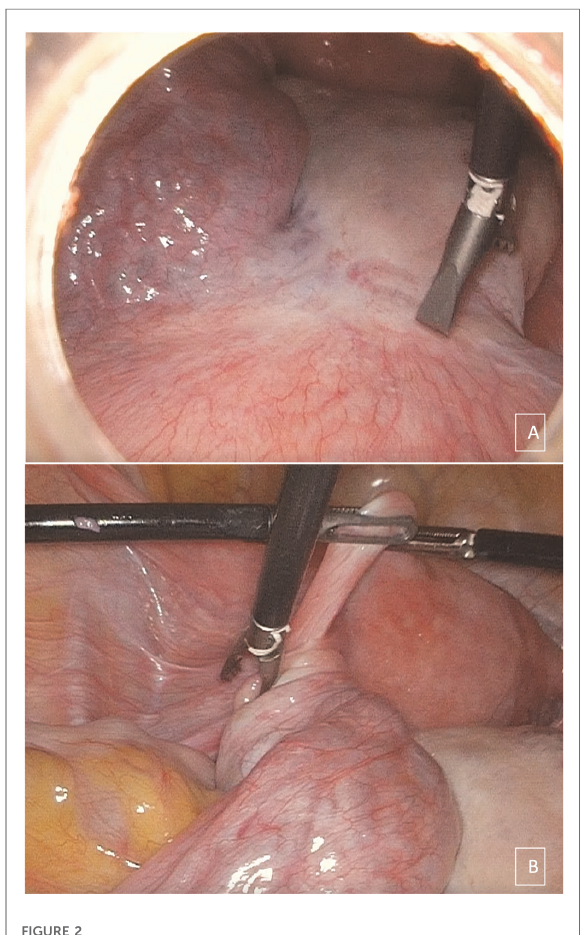
FIGURE 2 Laparoscopic appearance of part of the giant paratubal cyst ( A ) and of the convoluted left tube ( B ).